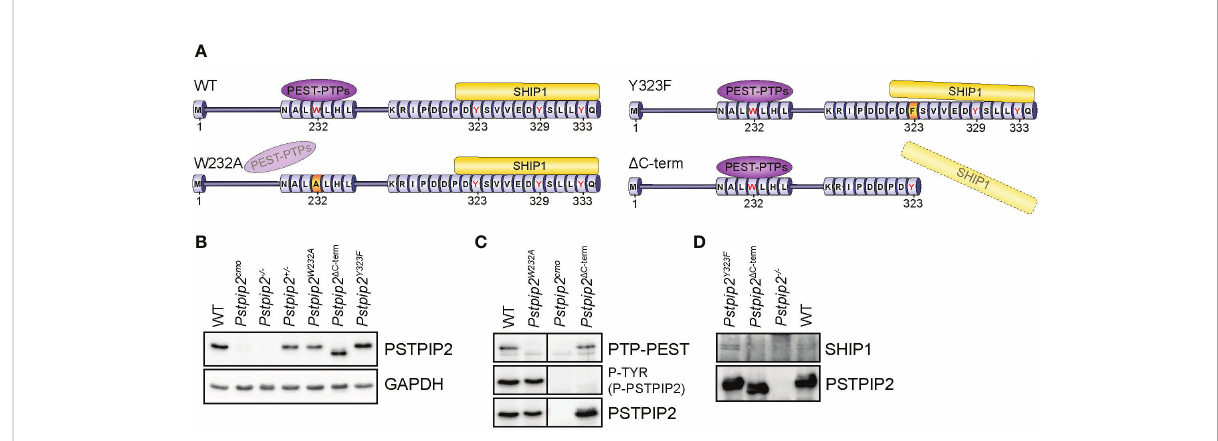
FIGURE 1 PSTPIP2 mutations in mice and veri fi cation of their effects on the interactions with binding partners. (A) Schematic representation of mutant PSTPIP2 proteins and their interactions in the individual mouse strains. (B) Lysates of puri fi ed neutrophils from WT and PSTPIP2 mutant mice were subjected to immunoblotting with the indicated antibodies to detect PSTPIP2 protein levels in the individual mouse strains. (C) PSTPIP2 was immunoprecipitated from the lysates of bone marrow cells from the indicated mouse strains. Co-immunoprecipitated PTP-PEST and PSTPIP2 tyrosine phosphorylation were detected by immunoblotting with PTP-PEST and phosphotyrosine antibodies, respectively. (D) Similar experiment as in (C) to detect interaction of PSTPIP2 with SHIP1. To maximize PSTPIP2 phosphorylation, cells in (D) were treated with